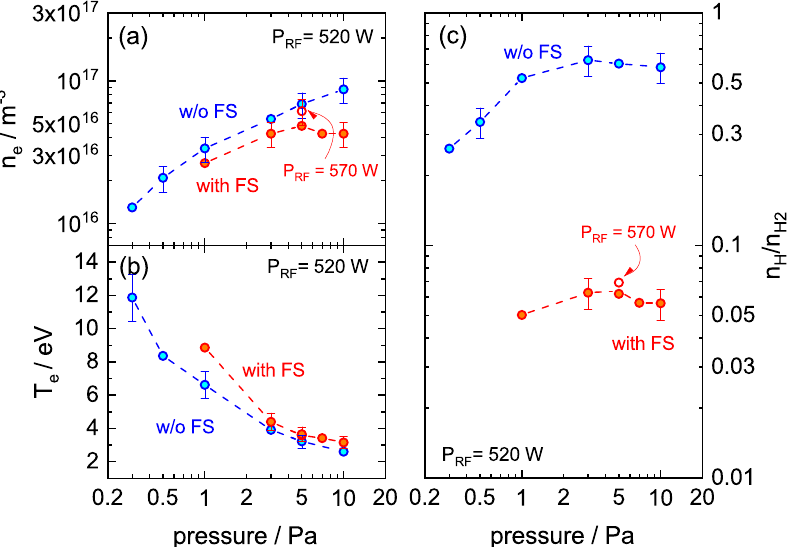
Figure 3. ( a ) Electron density, ( b ) electron temperature and ( c ) density ratio of atomic to molecular hydrogen of ICPs with and without Faraday shield. All parameters are plotted against the